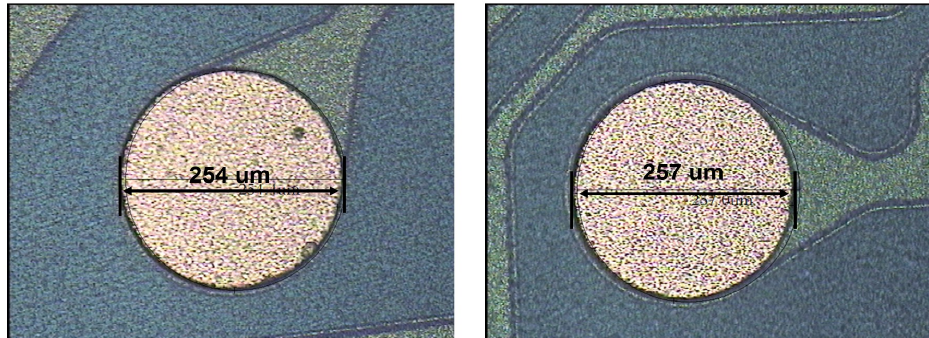
Figure 17. The OM image of SMF and UBM opening.